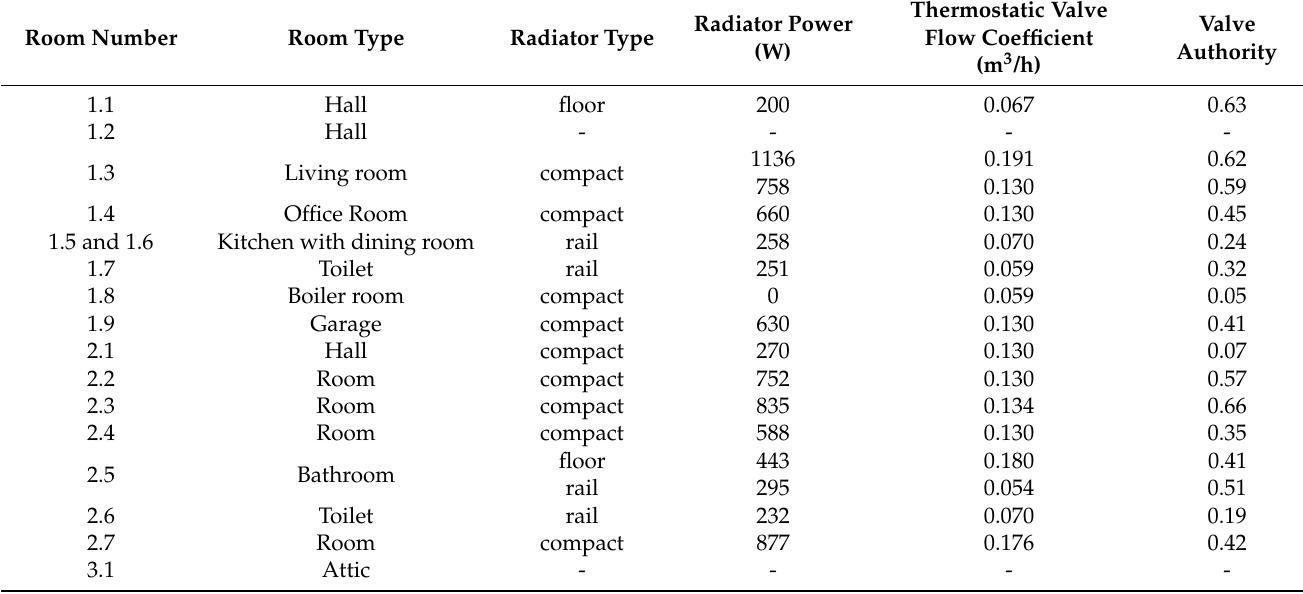
Table 3. Characteristic parameters of the heating